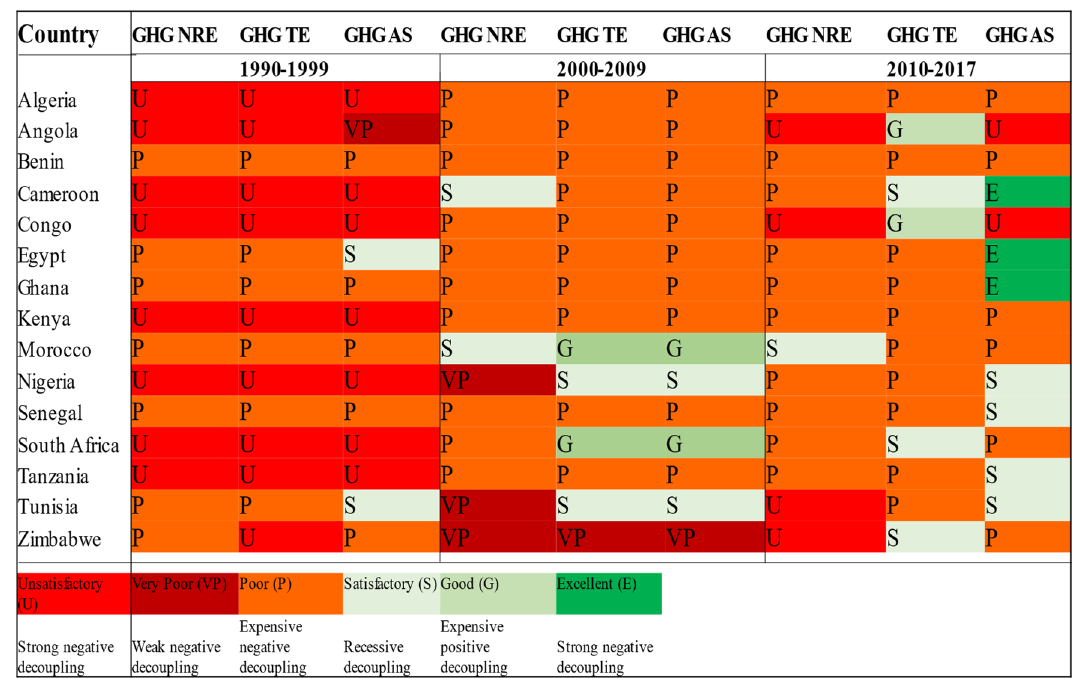
Figure 3. Decoupling GHG with economic growth.